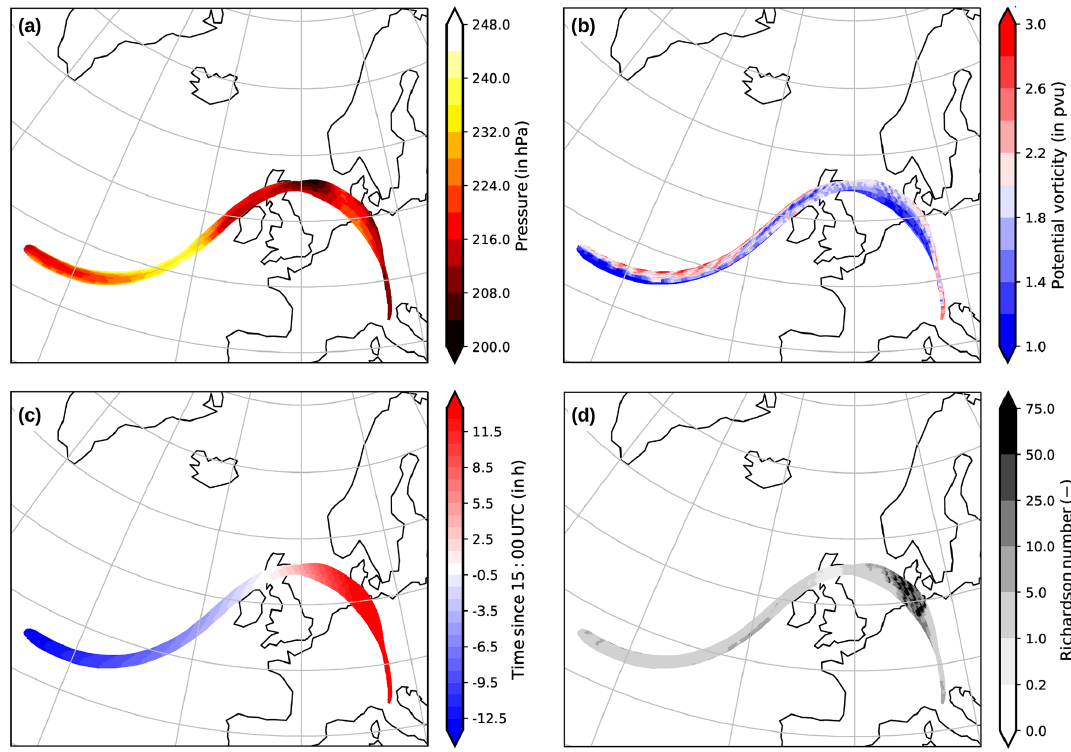
Figure 7. Trajectories crossing the 2pvu isosurface and encountering a dynamic instability which cross the flight track between 14:36 and 14:48UTC while HALO was flying on FL380. Trajectories start on 28 September 2017 at 01:00UTC and end on 29 September 2017 at 11:00UTC. The four panels show the following quantities along the trajectories: (a) pressure (in hPa), (b) potential vorticity (in pvu), (c) time since 15:00UTC (in h), and (d) Richardson number. In total each panel shows 12375 individual